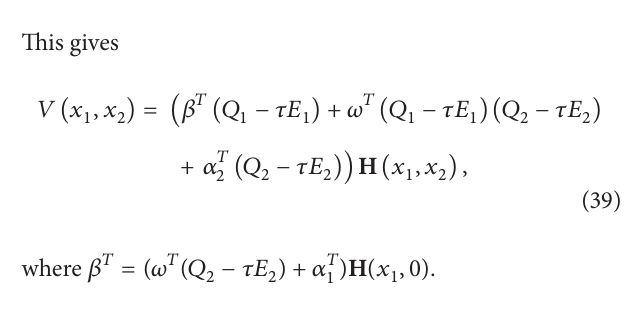
Figure 6: Optimal feedback control for Example 3 via the SHWCM with 𝑚 = 8, 16, 32 and 𝑥 1 = −0.1250, −0.0625, −0.0313 , respectively.